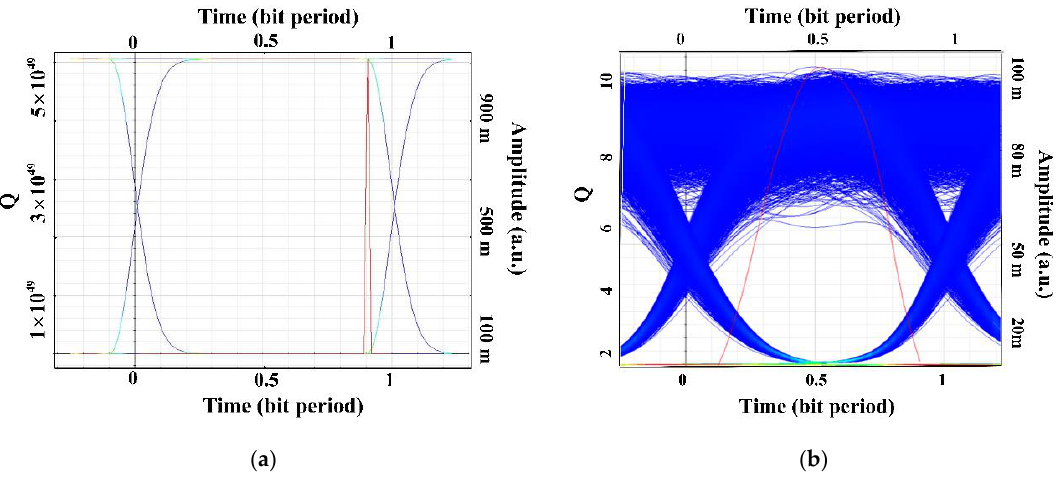
Figure 7. Eye diagrams of ( a ) downstream; ( b ) upstream link after 10 km transmission distance.